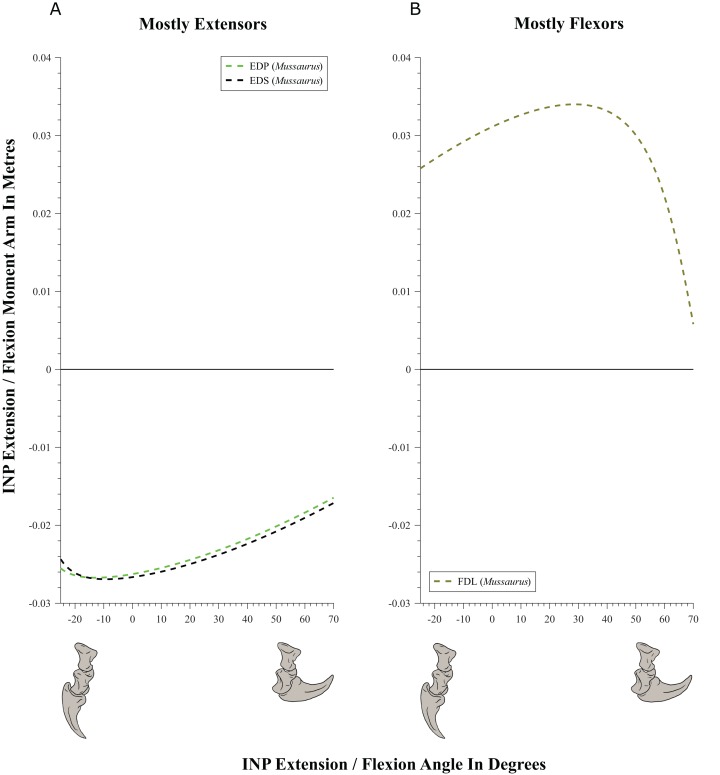
Extension/flexion moment arms (not normalized) around the interphalangeal (INP) joints, plotted against flexion/extension joint angles for Mussaurus.(A) Extensors; (B) flexors. Negative moment arms and joint angles correspond to extension, while positive values correspond to flexion. For muscle abbreviations see Table 1.